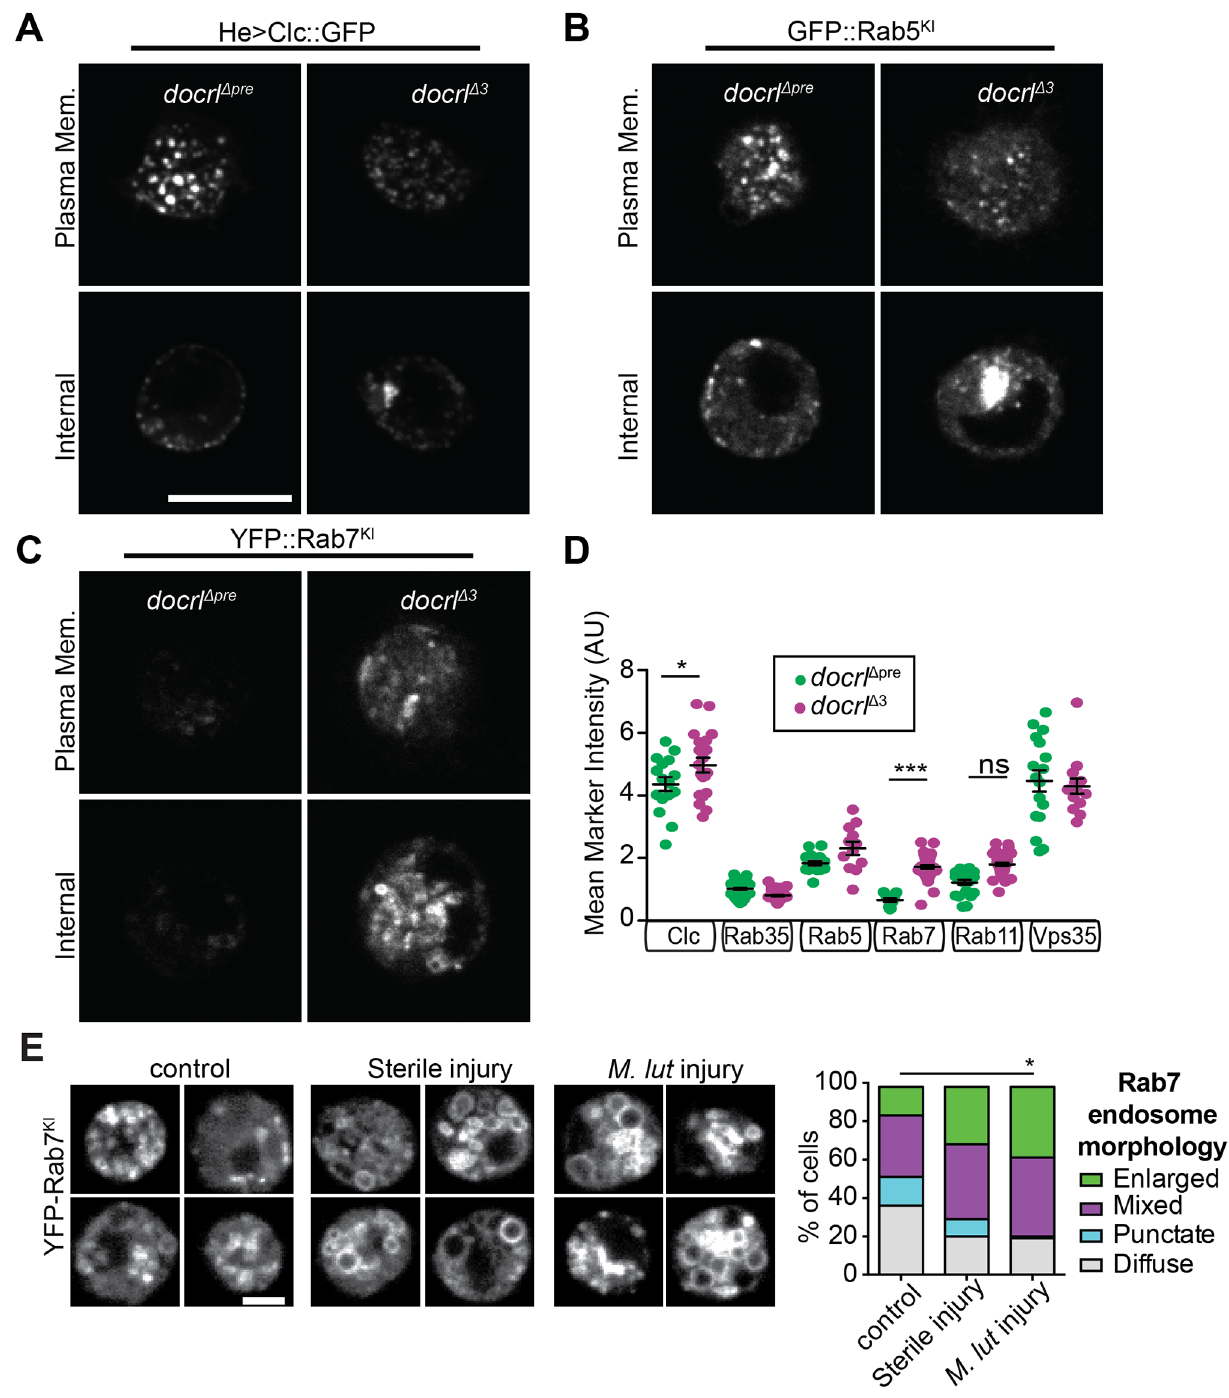
Fig 5. Aberrant endosomal compartment structure in docrl mutants. (A-C) Loss of docrl disrupts the structure of multipleendosomal compartments, includingfragmentation and perinuclearaccumulation of Clc (A) and Rab5 (B), and expansionof Rab7 (C). Images show singleconfocalslices at the plasma membraneand an internalZ plane. Scale bar is 10 μ m. (D) Quantificationof endosomalcompartment levels in docrl Δ 3 mutants. Rab7 levels are increased~3 fold, while Clc and Rab11levels are slightly increased. N in panel D represent individual cells equallypooledfrom three independent sets of larvae. (E) Hemocytes from injured wild-typelarvaeexhibit defective Rab7-positive endosomestructure. Scale bar is 5 μ m. All panels are representative single confocalslices from live primary hemocytes. Associated with S5